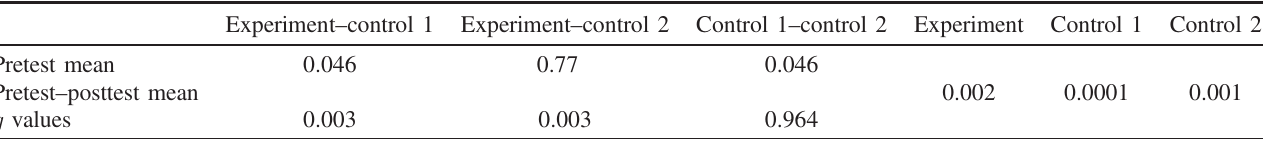
TABLE IV. Two-tailed p values for the t -tests of mean